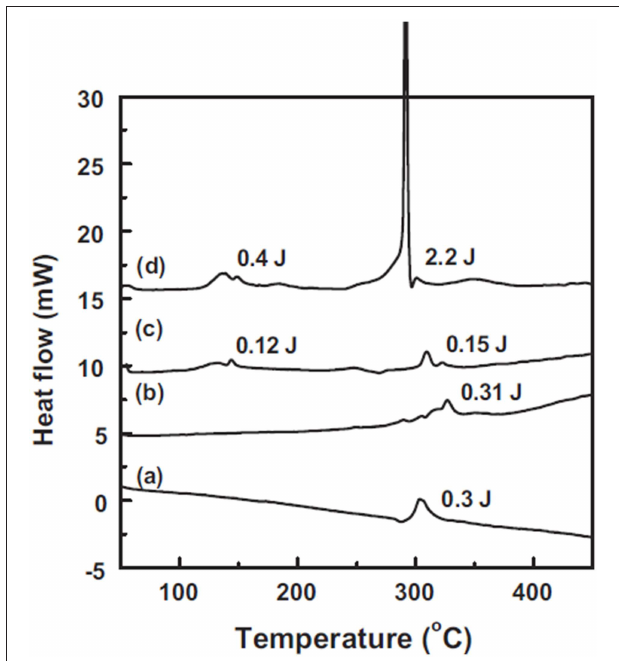
FIGURE 5 | DSC curves of (a) 0.5 µ L, 1M LiPF 6 /EC-DMC (1:1, v/v) electrolyte and a mixture of 0.5 µ L electrolyte and 0.5mg of (b) pristine Si/C electrode, (c) delithiated Si/C electrode, and (d) lithiated Si/C electrode. Reprinted from Zhao et al. (2012). Copyright (2012), with permission from Elsevier.